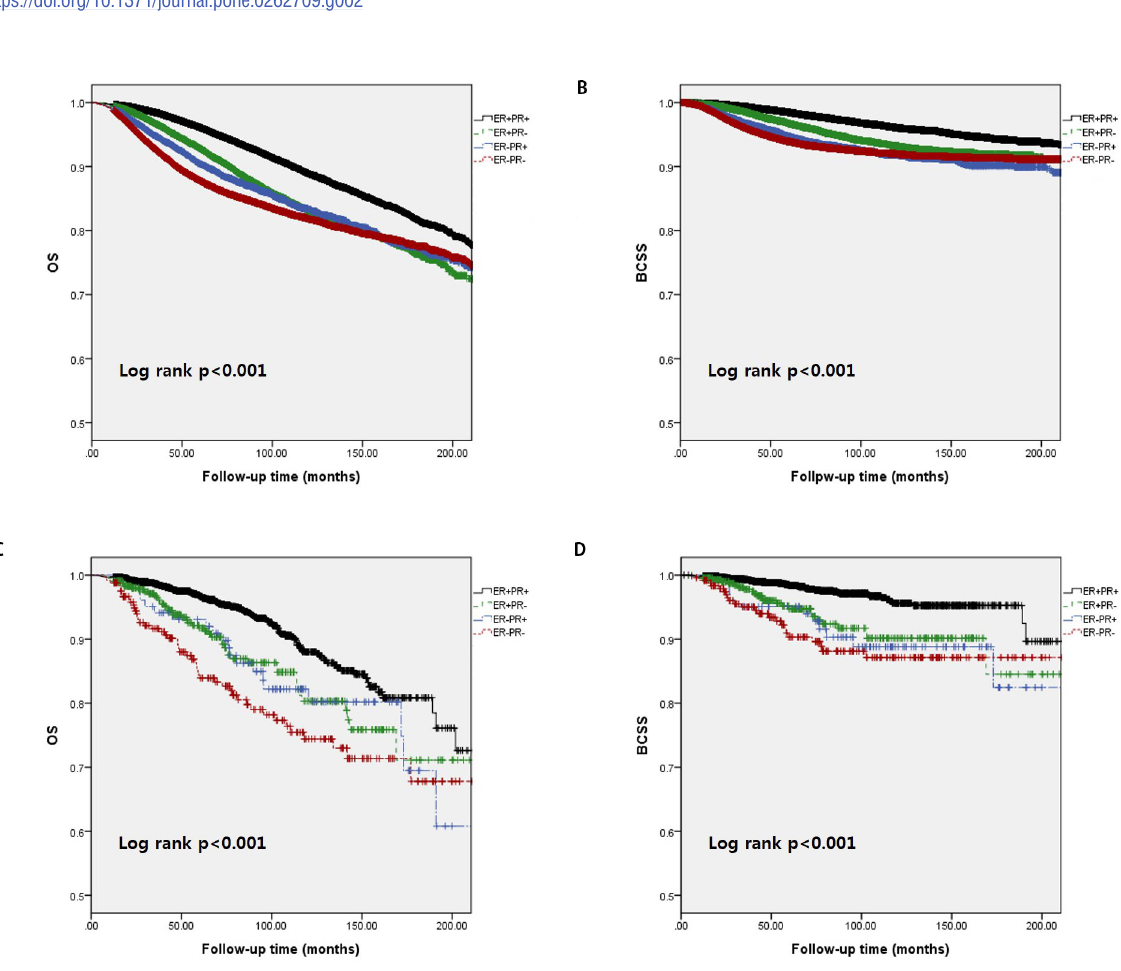
Fig 3. Kaplan–Meier survival analysis of overall survival (OS) (A, C) and breast cancer-specific survival (BCSS) (B, D) in the invasive ductal carcinoma (A, B) and invasive lobular carcinoma groups (C, D).